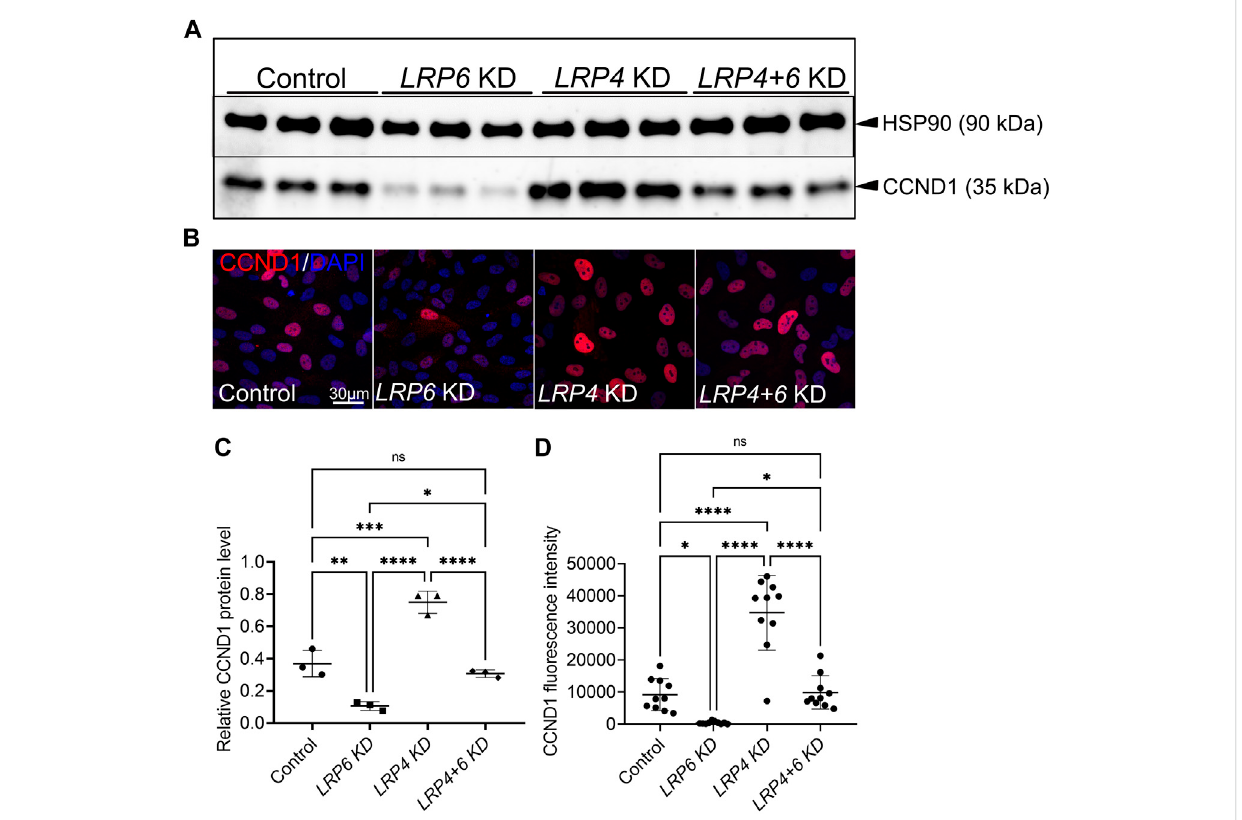
FIGURE 7 LRP4 modulates of LRP6-dependent Cyclin D1 levels in human TERT RPE-1 cells. (A, C) Western blot analysis and quanti fi cation of Cyclin D1 (CCND1)proteinlevelsafter Lrp6 siRNAandcontrolsiRNAtreatmentrespectively, demonstratedsigni fi cantly lowerCyclinD1proteinlevelshTERTRPE-1 cells after LRP6 silencing. Signi fi cant upregulation of Cyclin D1 levels were observed in cultures where LRP4 was silenced compared to cultures treated with control siRNA. Simultaneous silencing of LRP4 and LRP6 showed Cyclin D1 levels comparable with controls and therefore a rescue of decreased Cylin D1 levels in cells with LRP6 silencing. Quanti fi cation of Cyclin D1 levels was normalized to HSP90 (heat shock protein 90) signals. Three independent experiments in triplicates are summarized in the graphs. Signi fi cance assessed by one-way ANOVA. p values: * p < 0.05, ** p ≤ 0.01, *** p ≤ 0.001,**** p ≤ 0.0001;dataaremean±s.d. (B,D) CyclinD1positivecellsaredetectedinhTERTRPE-1culturesbyimmunocytochemistry.LRP4silencing resulted in higher levels of Cyclin D1 positive cells compared to controls. Signi fi cantly less Cyclin D1 positive cells were counted in cultures treated with siRNA to silence LRP6 compared to control siRNA treated cultures. This decrease in Cyclin D1 levels, caused by LRP6-depletion, was rescued by simultaneous silencing of LRP4 and LRP6. Scale bar = 30 μ m. Cyclin D1 signal intensity quanti fi cation was normalized to DAPI positive cell